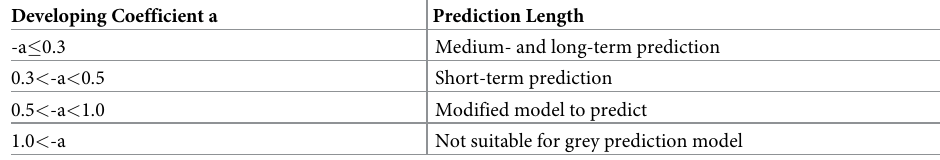
Table 2. The applicable scope of the GM (1,1) model.